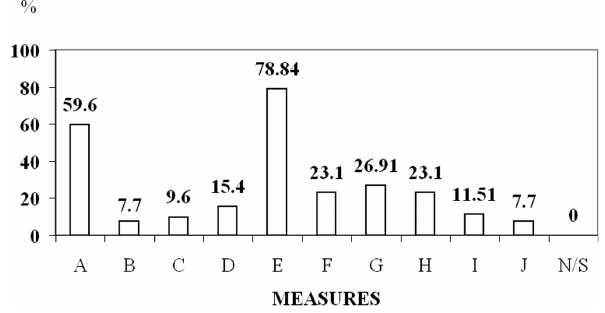
Fig. 7. Preferences for different management measures. Affected permanent residents.